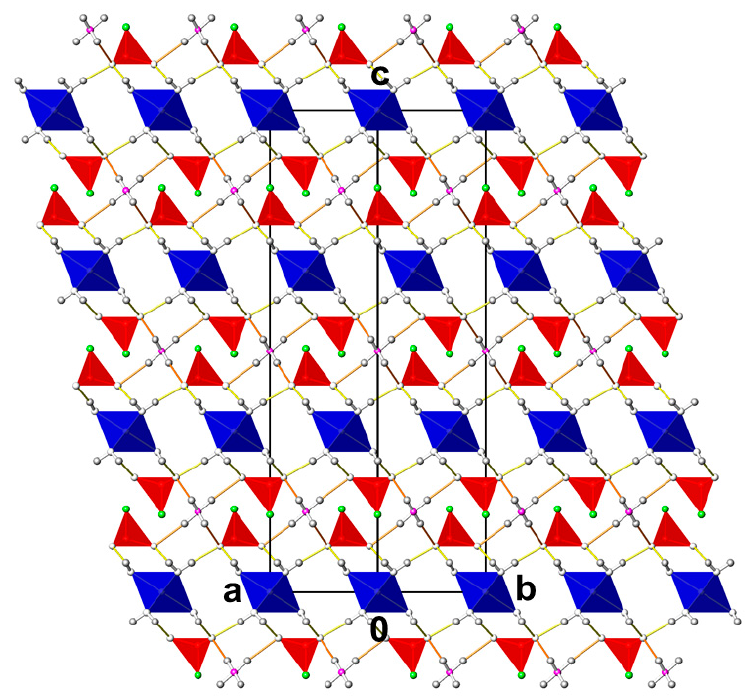
Figure 9. The crystal structure of NH 4 Cr(PO 3 F) 2 (H 2 O) 6 in a projection along [110]. Colour code as in Figure 6.